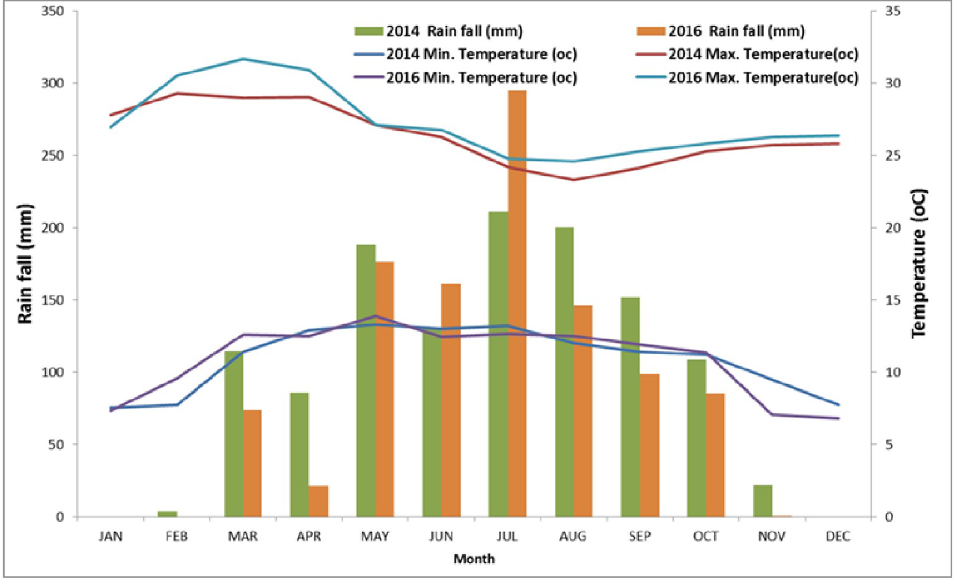
Fig 1. Mean monthly rainfall and temperature distribution in the two experimental years (2014 and 2016) at Adet.